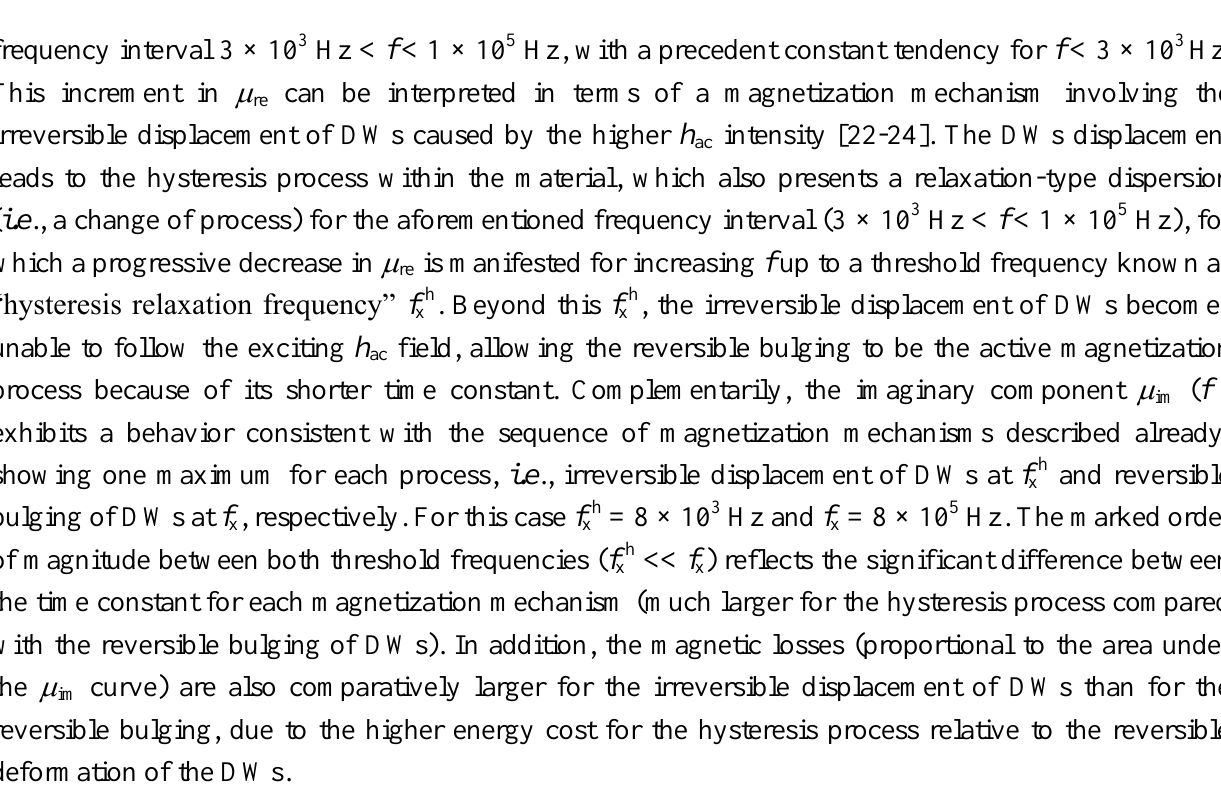
Figure 2. Spectroscopic plots of the complex permeability components for amorphous Fe B Si ribbon at h = 1.69 80 10 10 ac